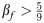
Scatterplot of the bimodality coefficient of the tolerance distribution βf at the end of simulations, against native share of the population (NatShare).Treatments were merged here due to their similarity. The critical value βf>59 is denoted by the horizontal red line.